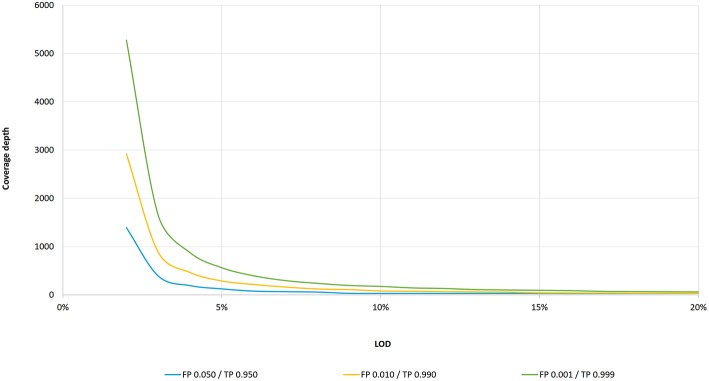
LOD as a function of coverage depth according to the binomial distribution. Coverage depth needed to maintain an intended LOD (within 3–20% VAF range) for three cumulative probability settings: for false positive probability of 0.001 and true positive of 0.999, a LOD of 20% is achieved at 61 coverage depth, a LOD of 10% at 175, a LOD of 5% at 562, and a LOD of 3% at 1,650. For the false positive probability of 0.010 and true positive of 0.990, a LOD of 20% is achieved at 31, a LOD of 10% at 81, a LOD of 5% at 288, and a LOD of 3% at 886 coverage depth, respectively. For the false positive probability of 0.050 and true positive of 0.950, a LOD of 20% is achieved at 30, a LOD of 10% at 30, a LOD of 5% at 124, and a LOD of 3% at 392 coverage depth, respectively.